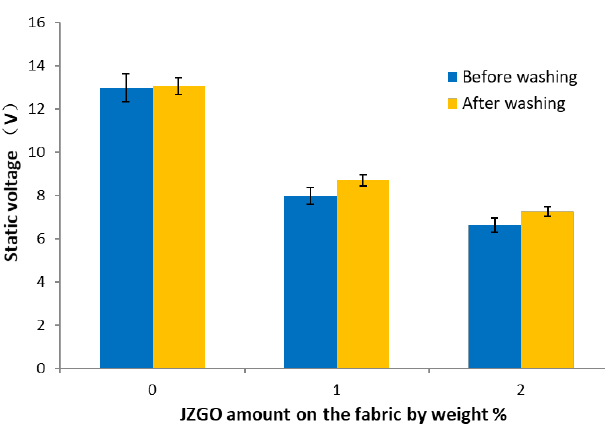
Figure 11. Static voltage of cotton fabric: ( a ) JZGO-modified cotton fabric; ( b ) JZGO-modified cotton fabric with three soap washings.